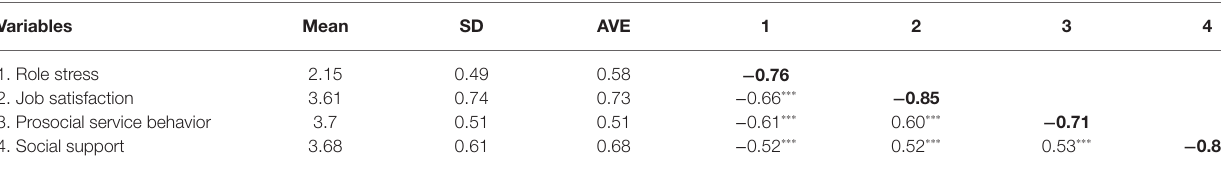
TABLE 3 | Means, standard deviations, and correlations of observed variables. Variables